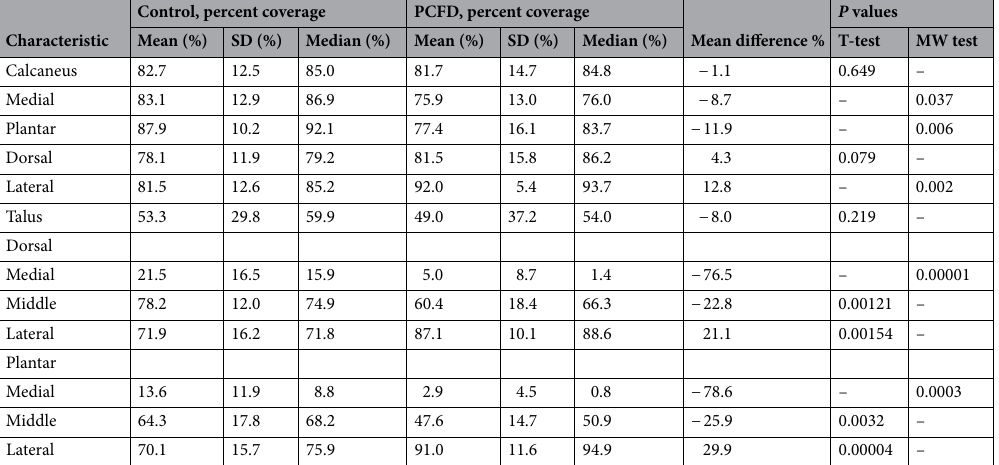
Table 2. Means, medians, and standard deviations for 3-dimensional coverage maps, measured in percent coverage, and mean differences in the coverage percent in the Chopart joint when comparing patients with progressive collapsing foot deformity and controls, with P values for the comparisons. MW test Mann– Whitney U test, SD standard deviation, PCFD progressive collapsing foot deformity.